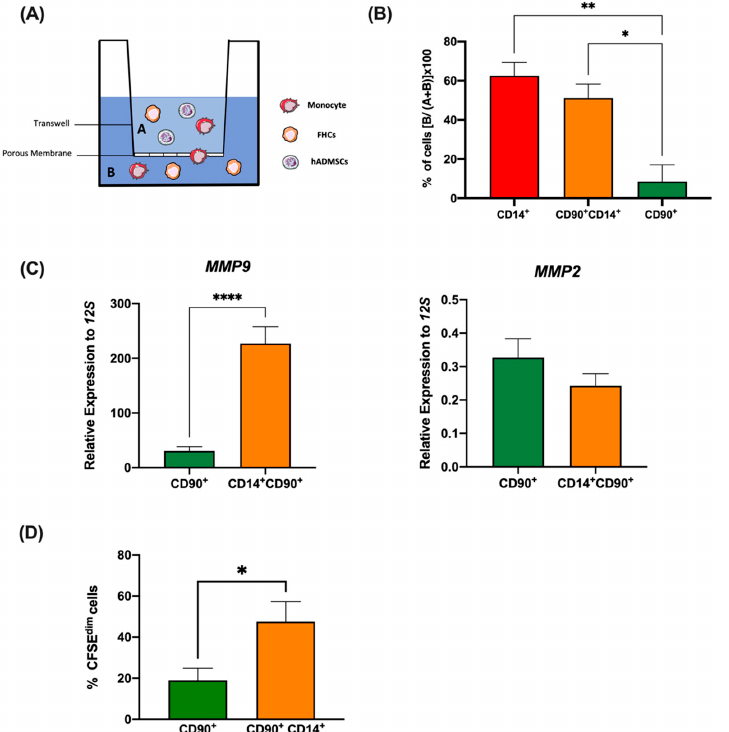
Figure 4. FHCs acquire enhanced migratory and proliferative abilities. ( A ), Schematic representation of the migration assay. Cells resulted from fusion assay were put on the top chamber (A), then migrating cells were quantified in the bottom chamber (B) by FACS. ( B ), Percentages of migration, % of cells [B/(A + B)] × 100 of CD14 + human monocytes (red), CD90 + hADMSCs (green), and CD90 + CD14 + FHCs (tangerine) from the trans-well assay are shown (n = 4). *, p < 0.05; and ** p < 0.01 in ordinary one-way ANOVA with Tukey’s multiple comparison post-hoc test. ( C ), Relative expression by RTqPCR of MMP9 and MMP2 in CD90 + hADMSCs (green) and CD90 + CD14 + FHCs (tangerine) sorted cells after 5 days of co-culture (n = 9). ****, p < 0.0001 in unpaired t -test. ( D ), Proliferations of CD90 + hADMSCs (green) and CD90 + CD14 + FHCs (tangerine) are shown. *, p < 0.05 in unpaired t test.